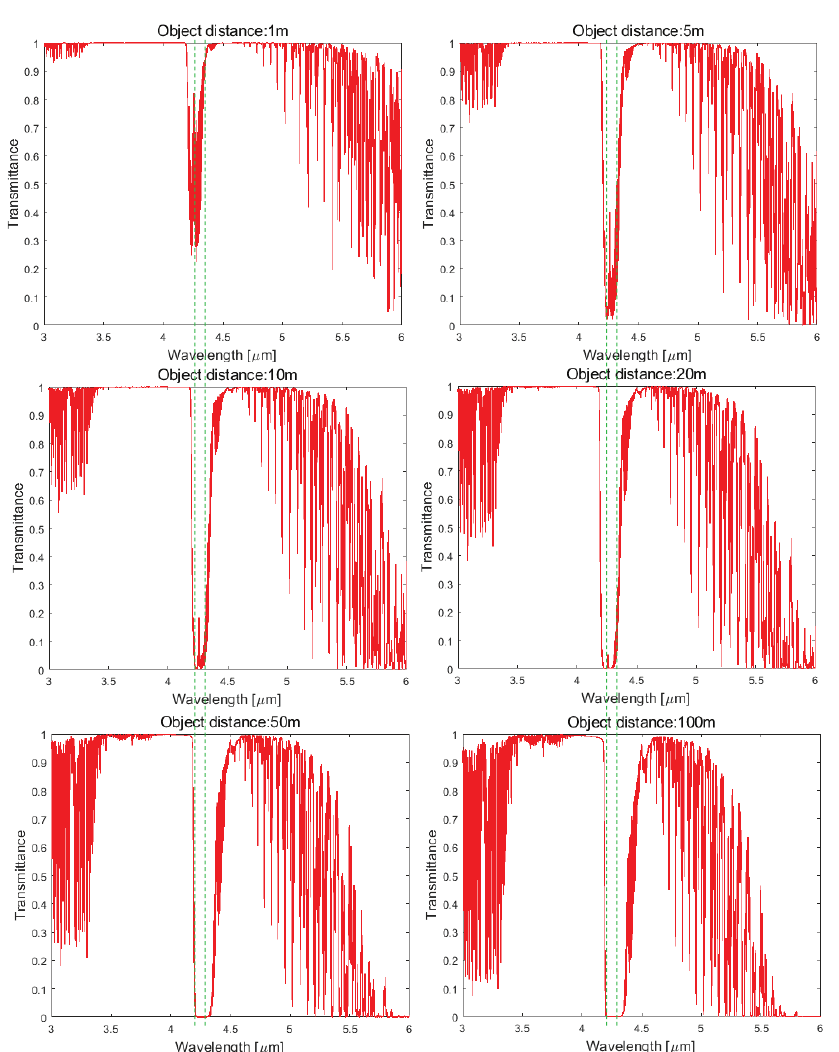
Figure 8. Spectral transmittance according to object-camera distance in the MWIR band. Note the abrupt absorption at 4.25–4.35 µ